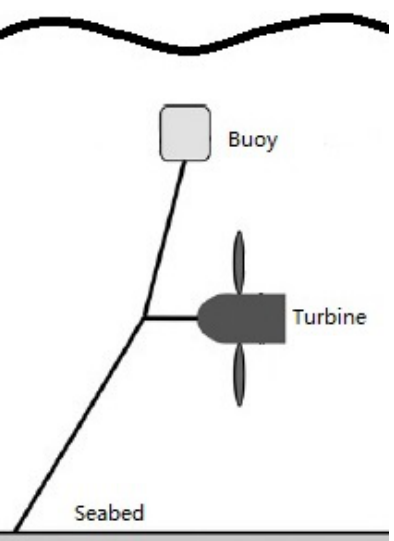
Figure 1. Schematic of tensioned mooring turbine in